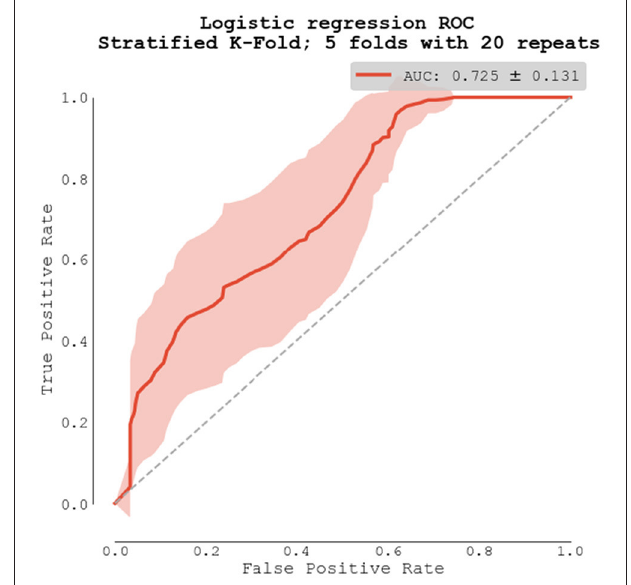
FIGURE 6 | Logistic regression model using repeated stratified K-Fold cross-validation